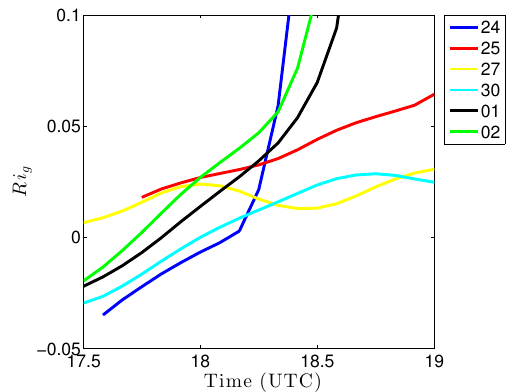
Figure 5. Temporal evolution of the Richardson number from 17:30 to 19:00 UTC on all the studied days at T1.